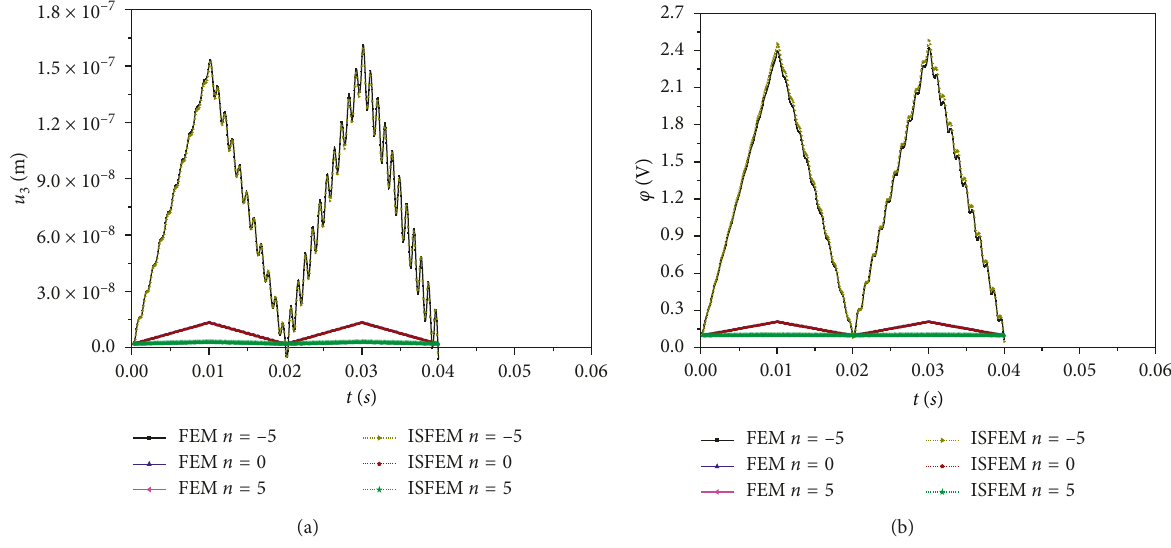
Figure 16: Variations of the displacement u 3 and electrical potential φ at the loading point with time of the FGPM beam based on PZT-5H when the gradient parameter was n � − 5, 0, and 5 under triangular load. (a) Displacement. (b) Electrical